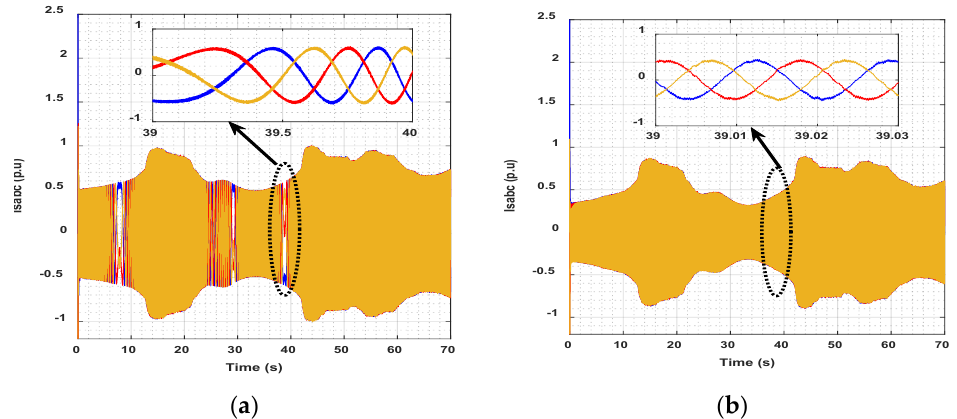
Figure 12. ( a ) Rotor current, ( b ) stator current waveforms under PIC.